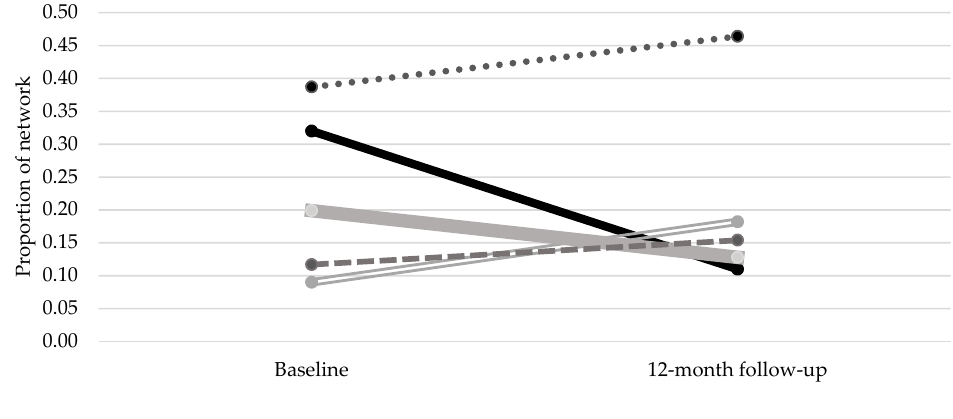
Figure 1. Network composition over time by proportion of relationship type (n = 13). * “Other” includes alters identified as neighbors, coworkers, clergy, fellow church members.